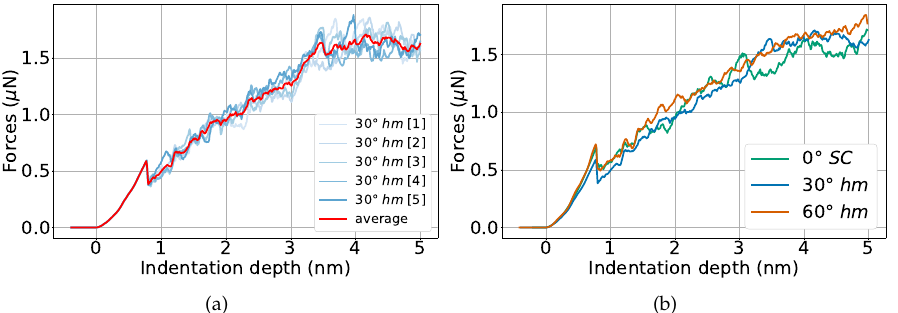
Figure 3. Force–depth curves for indentation into elemental Ni. ( a ) five individual simulations of indentation into a bi-crystal, containing a 30 ◦ grain boundary at 3 nm depth; ( b ) comparison of the averaged force–depth curves for indentation into bi-crystals containing a 30 ◦ or a 60 ◦ grain boundary with that of a single